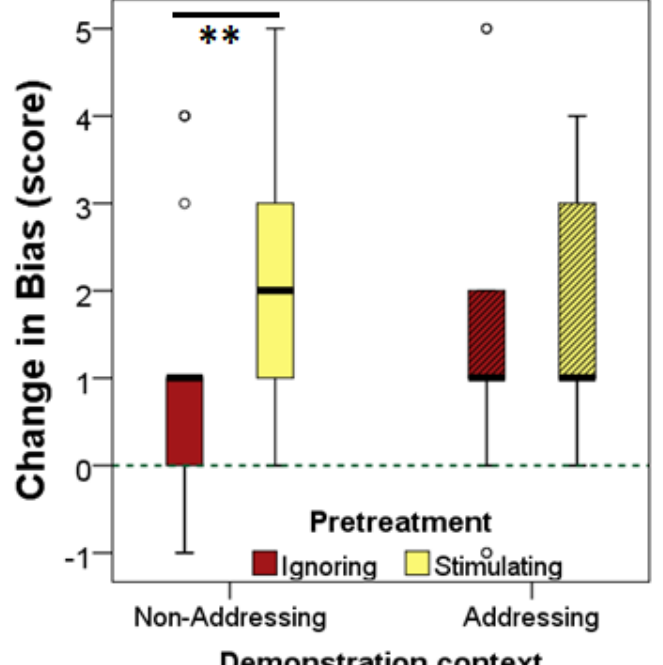
Figure 2. Change-in-bias scores of the four experimental groups in Experiment I. Larger values indicate a greater influential effect of the human demonstrator (preference for the smaller amount). Medians are represented by bold lines; boxes indicate the lower and upper interquartile range and whiskers extend to the smallest and largest values excluding outliers and extremities. Asterisks (**) indicate significant difference between dogs received socially stimulating (STIM) and ignoring (IGN) pre-treatment in the non-addressing demonstration context at p < 0.01.